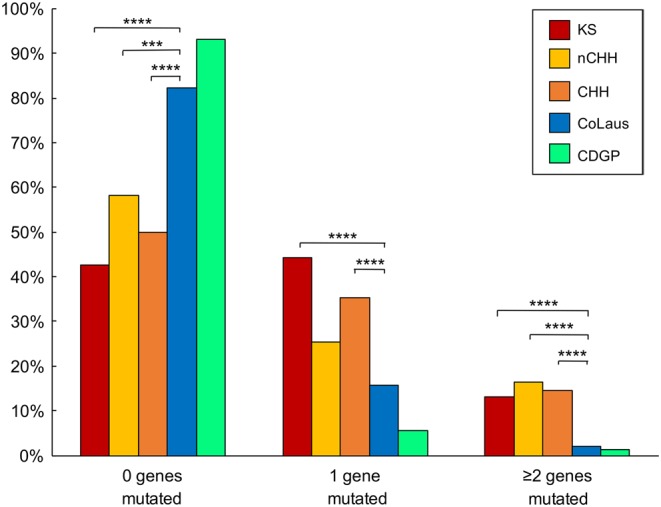
Oligogenicity is a common factor in CHH, and it is not found in CDGP. Histogram showing the frequency of KS (red), nCHH (yellow), CHH (orange), CoLaus (blue) and CDGP (green) individuals having no rare variants in CHH genes, one gene mutated or at least two genes mutated (oligogenicity). Differences between KS, nCHH and CHH vs CoLaus controls were analyzed via a two-sided Fisher’s exact test. P < 0.05 was considered significant. *P < 0.05; **P < 0.01; ***P < 0.001; ****P < 0.0001. Not significant differences among KS, nCHH and CHH vs CoLaus are not displayed.